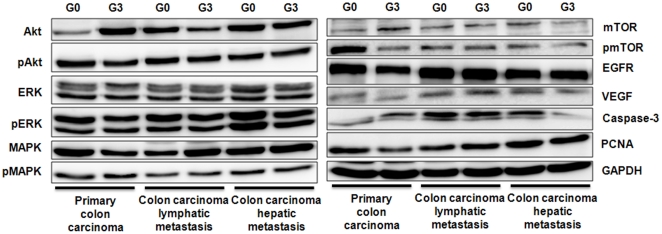
Exemplified immunoblotting data of the proteins Akt, pAkt (Ser308 and Ser473), ERK, pERK (Thr202/Tyr204), MAPK, pMAPK (Thr180/Tyr182), mTOR, pmTOR (Ser2448), EGFR, VEGF, Casepase-3, PCNA and GAPDH (as loading control) of primary colon carcinoma and its corresponding lymphatic and hepatic metastases and their early-generation xenograft tumor tissues.G0, the primary tumors; G3, the third generation of xenografts.